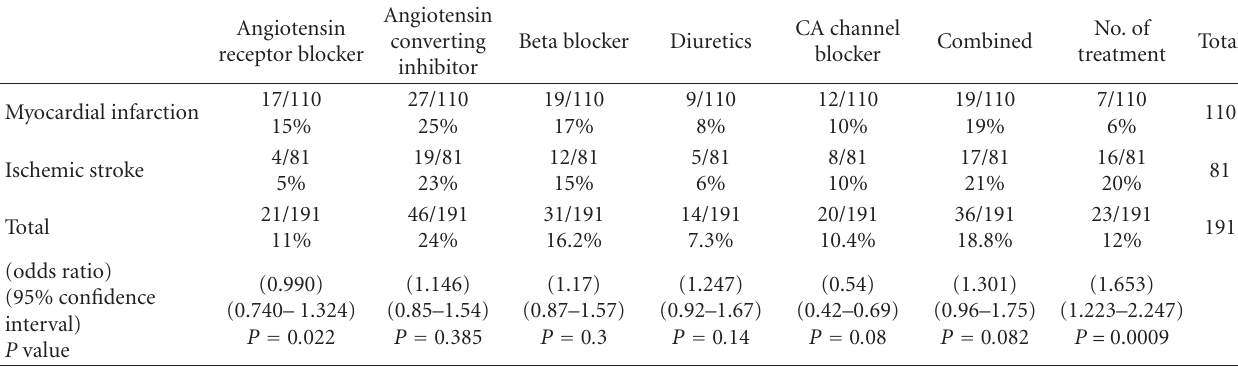
Table 4: Treatment drugs type in both groups of Myocardial infarction and